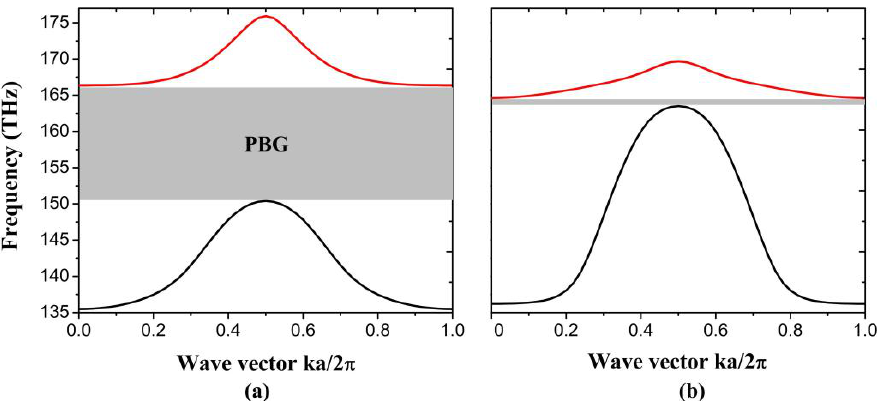
Figure 4. The first two bands of 1D PhC: ( a ) graphene nanoribbon with width of 13 nm; ( b ) graphene nanoribbon with width of 17 nm.